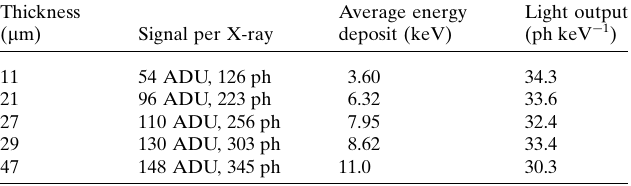
Table 4 Light output of the GOS:Tb scintillating screens measured at 15.4 keV (the X-ray generator settings are detailed in Section